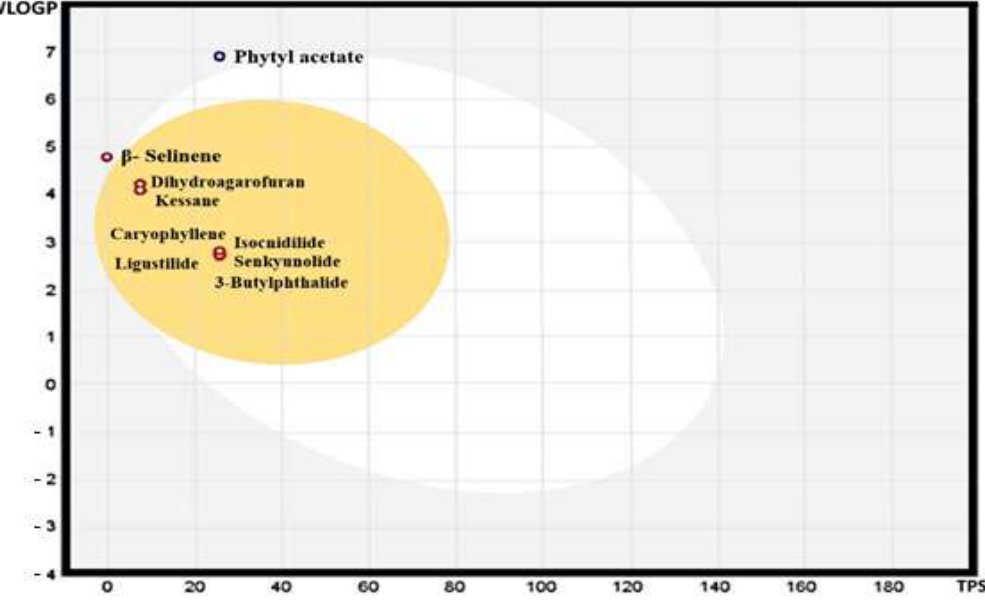
Figure 6. The graphical prediction (boiled-egg) of gastrointestinal absorption and brain penetration properties of selected compounds.